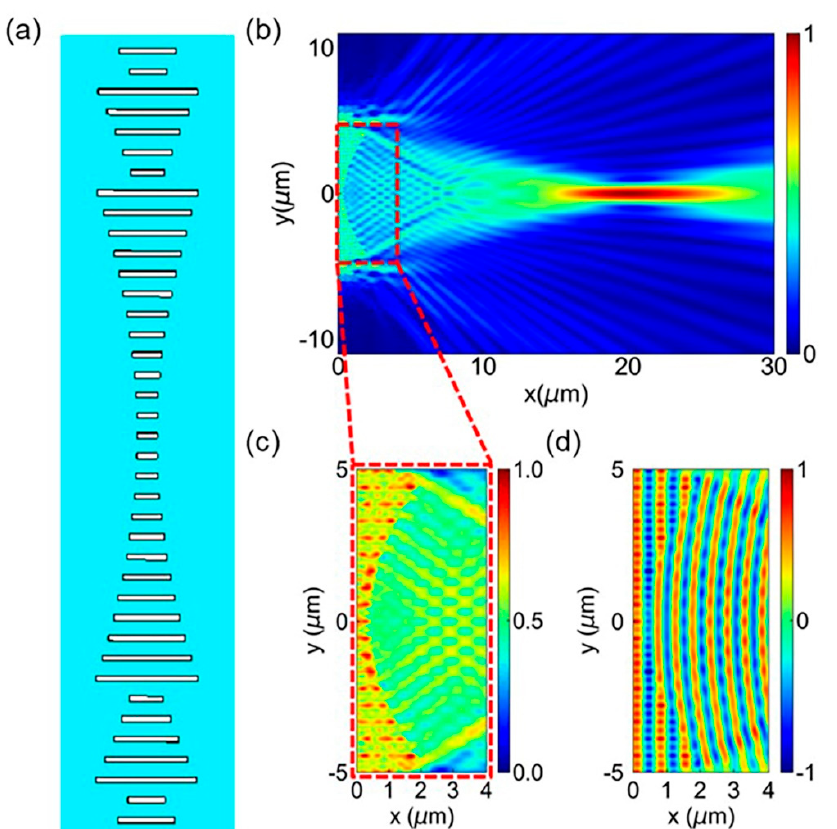
Figure 4. The design of on-chip metalens. ( a ) The structure diagram of the proposed metalens. ( b ) In-plane electric-field distribution |E y | in the middle of the silicon slab with incident light parallel to its optical axis. ( c , d ) Simulated electric-field distribution |E y | and E y in the region highlighted by a dashed red box in ( b ), respectively.